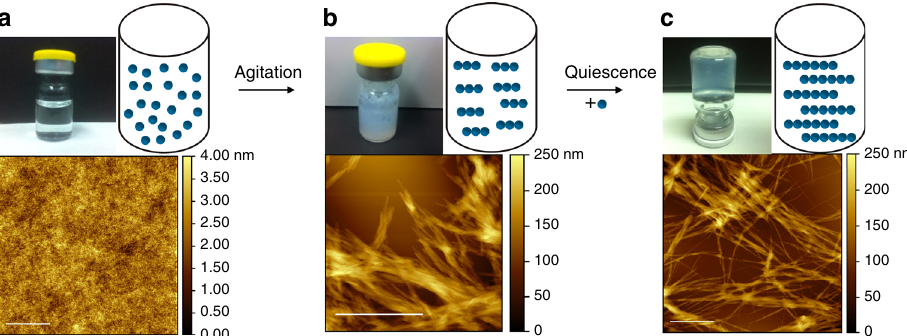
Fig. 1 Self-assembly of Oxm. a – c Photographs, schematic representations and AFM images of freshly prepared peptide at 10mg mL − 1 in 0.09% saline a , after 5 days of incubation with orbital shaking b and after incubation of 0.1 mgmL − 1 fi brils with a 10mgmL − 1 free peptide solution in water c . Scale bar, 1 μ